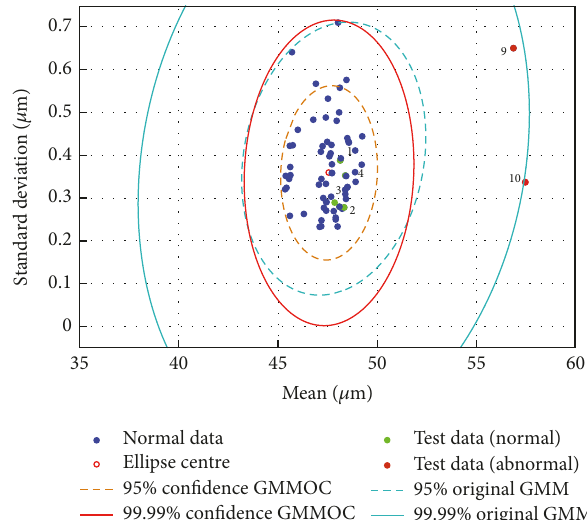
Figure 8: [CS1] GMMOC novelty detection results compared to those of the original GMM.